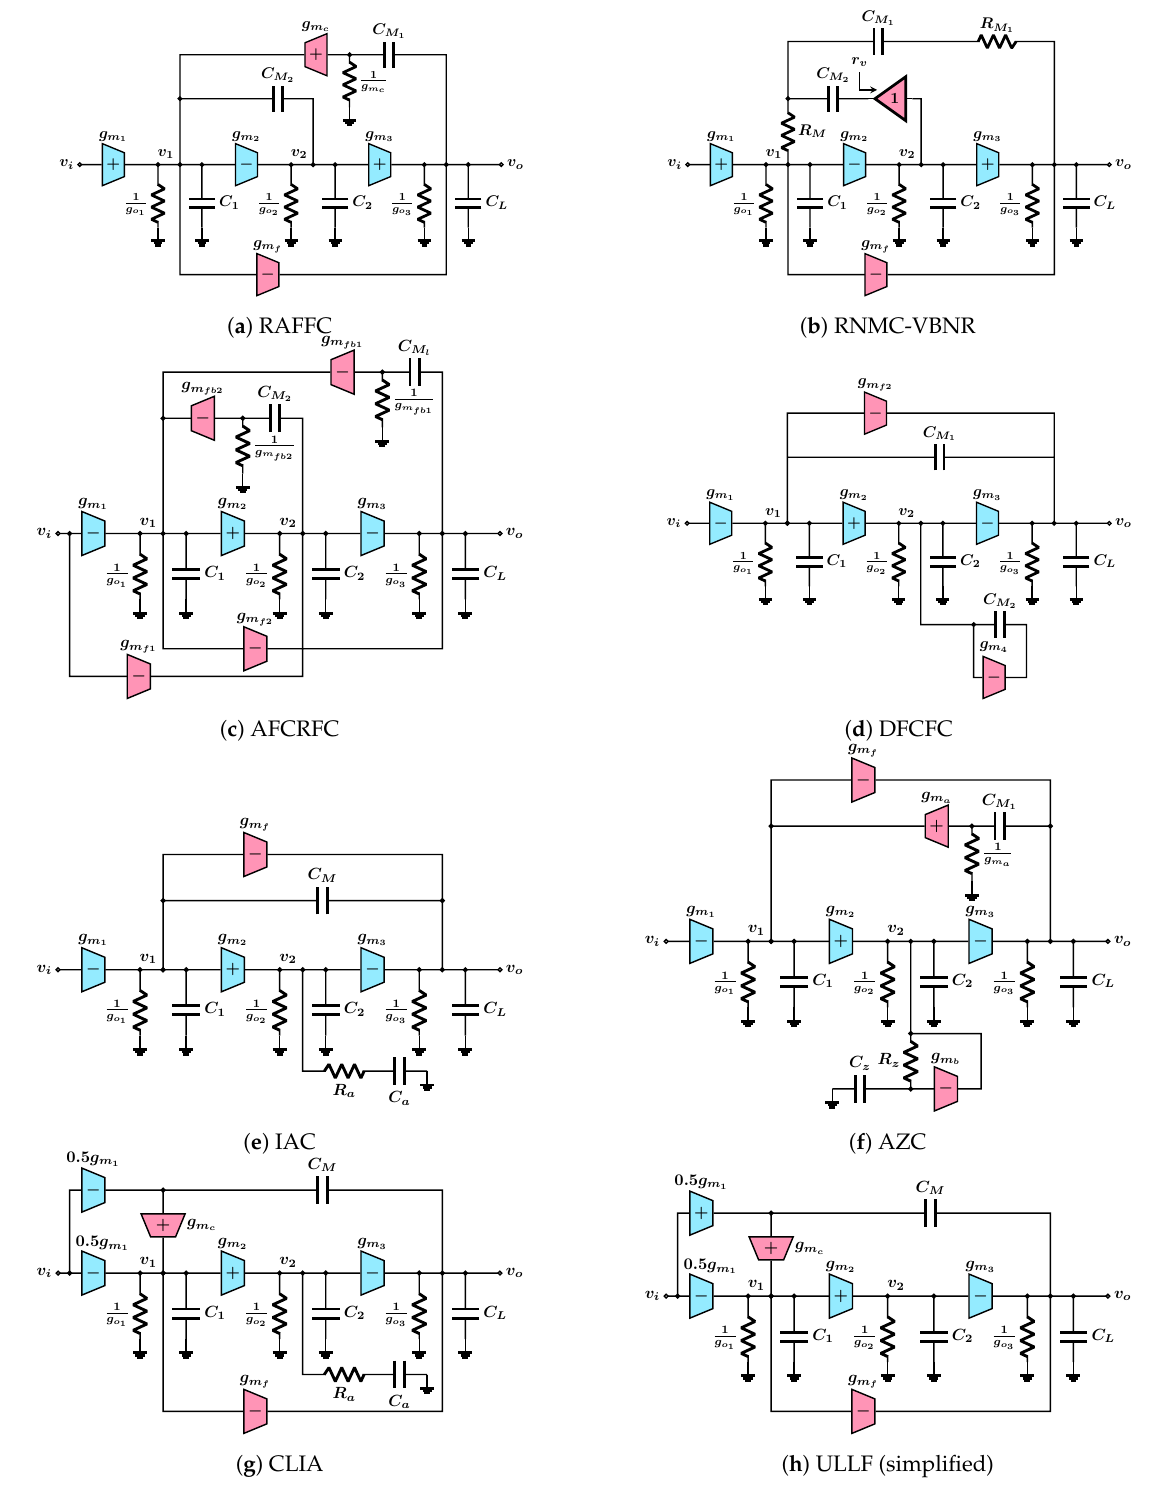
Figure 11. Compensation architectures with uncompensated inner amplifiers. Cyan blocks show the core amplifier stages while magenta blocks show additional transconductors used for